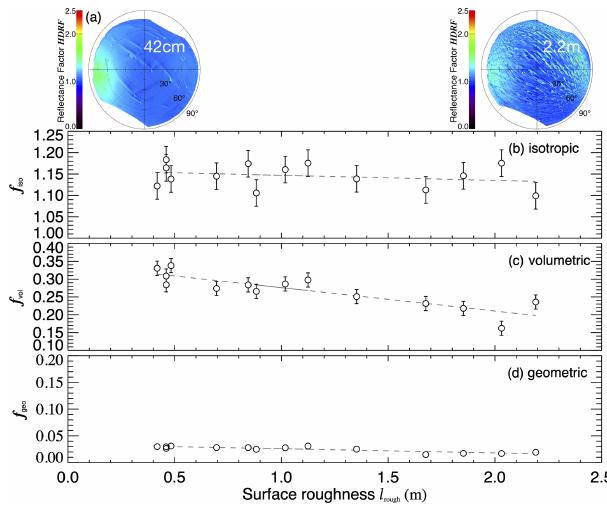
Figure 6. (a) Averaged snow HDRF (490–585nm wavelength) over 30s segment during easternmost flight leg for the five consecutive research flights on 28 December 2013. (b–d) Dependence of the re- trieved f k on the solar zenith angle θ 0 for the five flights. The dashed lines represent linear regression fits of the parameters with respect to θ 0 . (b) The isotropic weight f iso . (c) The volumetric weight f vol . (d) The geometric weight f geo .